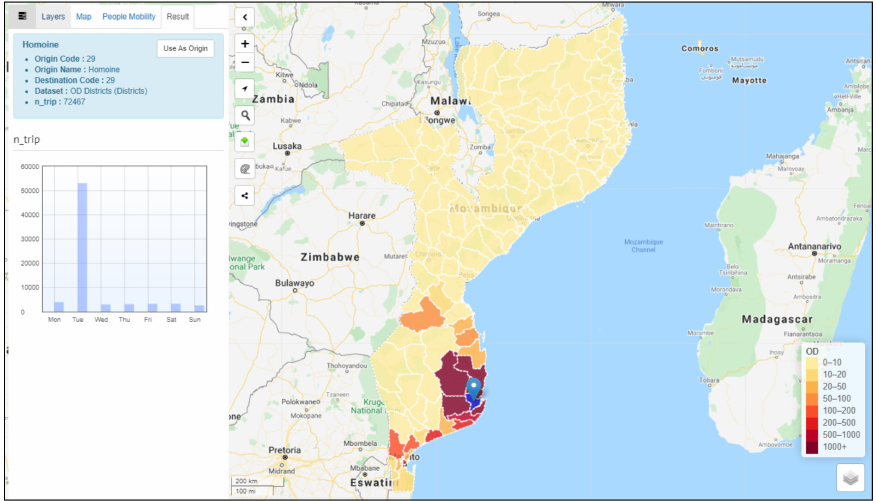
Figure 9. A result of the selected destination on a web